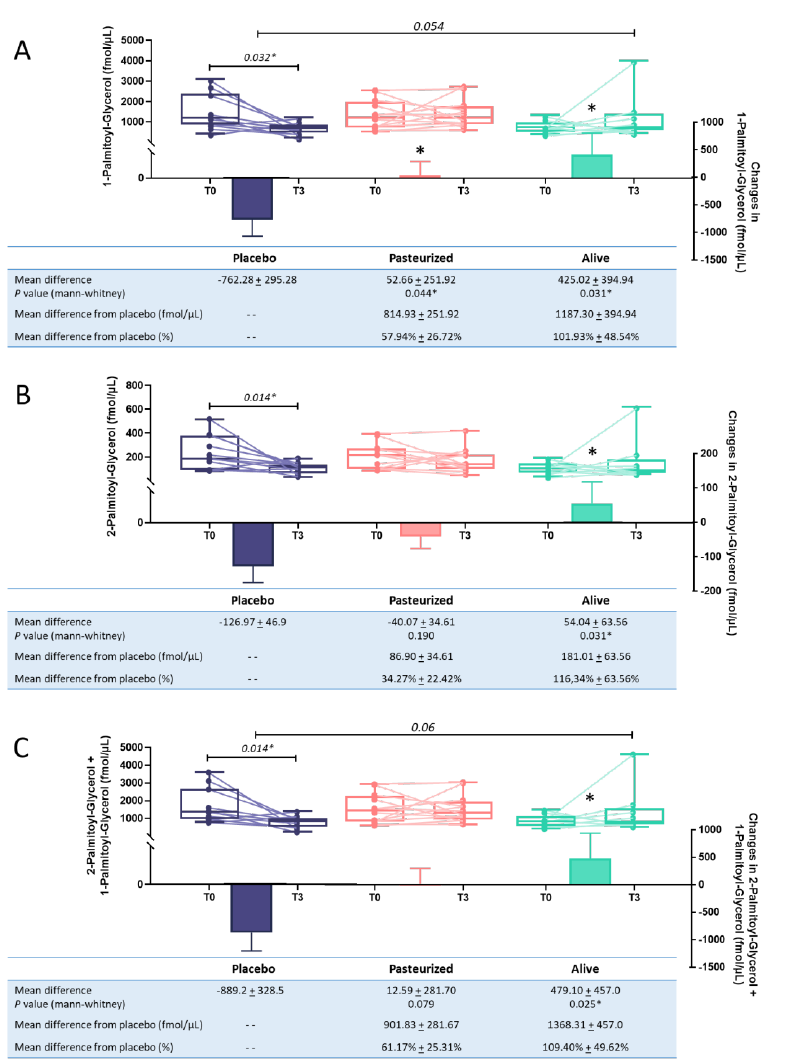
Figure 2. Evolution of plasmatic levels for 1-Palmitoyl-glycerol ( A ), 2-Palmitoyl-glycerol ( B ), and the combination of the 2 isomeric forms ( C ) following the intervention. Purple color was used for the placebo group, pink for the pasteurized group and green for the alive group. Differential values (mean difference and mean difference from placebo) are expressed as the mean ± s.e.m., either as raw data or as percentages. The “- -” in the table refers to “non applicable”. The bars represent the delta per group with the corresponding s.e.m., which corresponds to the mean difference between the value at the end of the intervention and the baseline value. Two-tailed Mann–Whitney U-tests were performed to compare the differential values of both treated groups versus the placebo group (intergroup changes). Below each plot are indicated the respective p -values and when the test is significant, the bars are marked with an asterisk. The horizontal lines represent the evolution of the raw values before and after the intervention. The box-and-whiskers plot illustrates the distribution of the raw values for each timing within each group. The line in the middle of the box is plotted at the median, while the superior and inferior limits of the box correspond to the 75th and the 25th percentiles, respectively. The whiskers correspond to the maximum and minimum values. Two-tailed matched-pairs Wilcoxon’s signed-rank tests were performed to verify changes from baseline (intragroup changes). When the difference is significant, a capped line is marked above the relevant group with the corresponding p -value. Changes between 0 and 3 months across the 3 groups were analyzed with Kruskal–Wallis test; group-wise comparisons were performed using Dunnet’s corrections for multiple testing. When the difference is close to significant, a line is marked above the relevant groups with the corresponding p -value. Placebo group, n = 11; pasteurized bacteria group, n = 12; alive bacteria group, n = 9. * p <